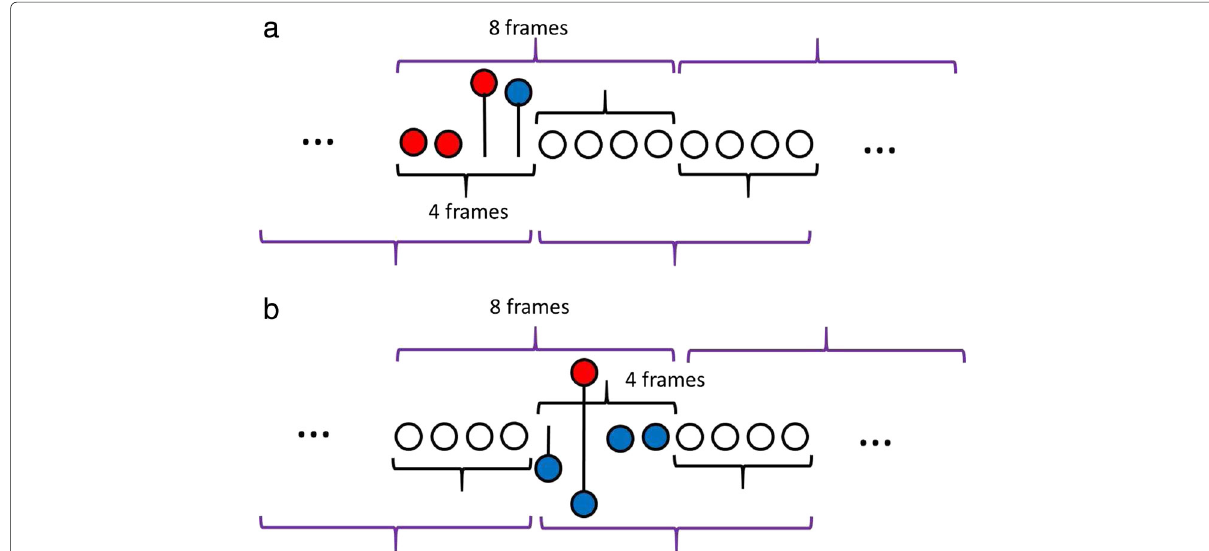
Fig. 4 Method of identifying the starting and ending points. a Starting point. b Ending